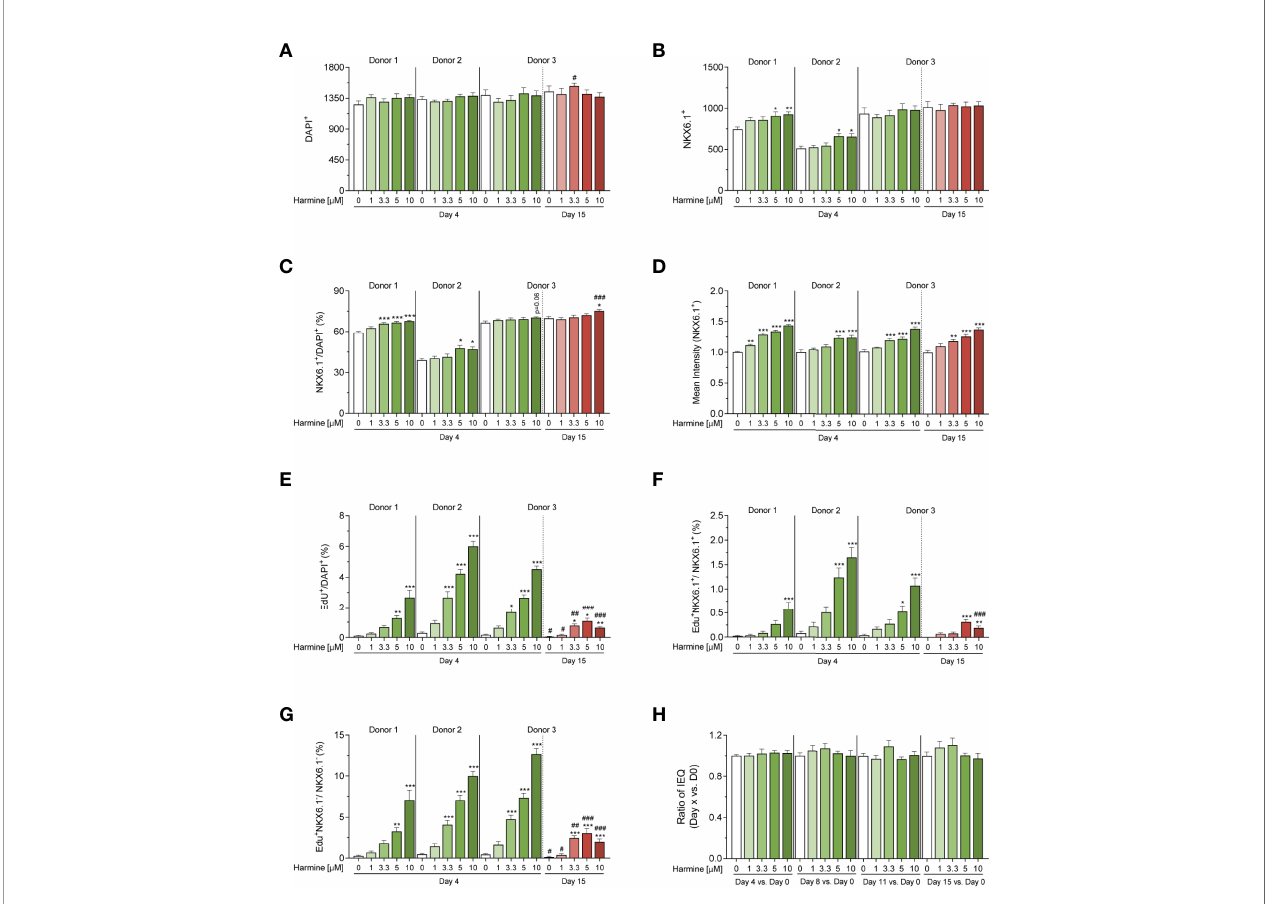
FIGURE 3 | 3D microscopy image analysis of harmine-induced proliferation in human islet MTs generated from 3 donors. (A – F) Quanti fi cation of (A) total cell number (DAPI-positive cell count), (B) total b -cell number (NKX6.1-positive cell count), (C) percent b -cell fraction (% NKX6.1/DAPI), (D) mean NKX6.1 intensity, (E) percent total proliferating cells (% EdU/DAPI), (F) percent proliferating b -cells (% EdU + NKX6.1 + /NKX6.1 + ), (G) percent proliferating non- b -cells (% EdU + NKX6.1 - / NKX6.1 - ), and (H) volume differences over time (Donor 3, 15-day treatment). (A – H) Data are represented as mean ± SEM, n = 6 – 12. Signi fi cance was determined by one-way ANOVA followed by Dunnett ’ s multiple comparisons test vs. the respective DMSO control (*p < 0.05, **p < 0.01, ***p < 0.001), or by student ’ s t-test for D15 vs. D4 comparisons between equal harmine doses ( # p < 0.05, ## p < 0.01, ### p <